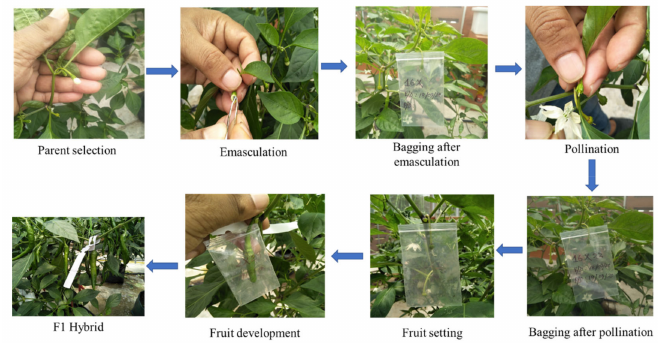
Figure 5. The technique of hybridization: In the previous evening before the flowers were opened, the desired flowers which were to be pollinated the next morning will be emasculated and covered with a plastic bag. On the following morning, the pollen of the targeted flowers was dusted on the female part and covered to avoid unwanted cross-pollination. Details about parents and pollination date have been put on a label. (Picture captured from author’s research